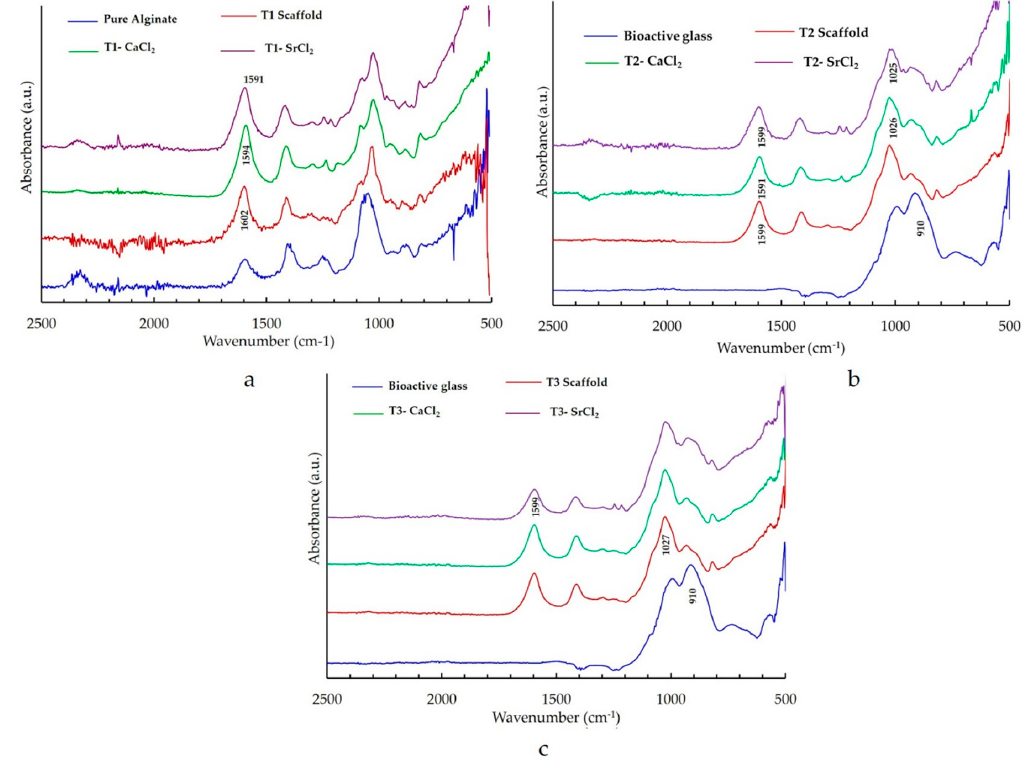
Figure 4. FTIR spectra showing the effect of crosslinking with calcium chloride (and strontium chloride in ( a ) type 1 (T1) bone scaffold (alginate only), ( b ) type 2 (T2) bone scaffold (alginate: bioactive glass: 1:1), and ( c ) type 3 (T3) bone scaffold (alginate: bioactive glass: 2:1).